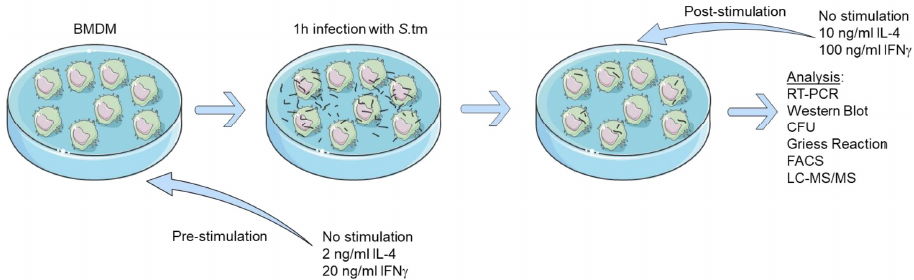
Figure 1. Schematic representation of in vitro stimulation and infection of BMDM with S .tm.